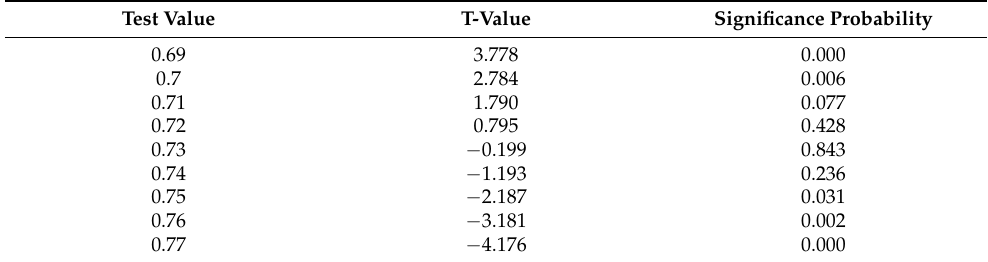
Table 5. Significance probability according to test value of validation